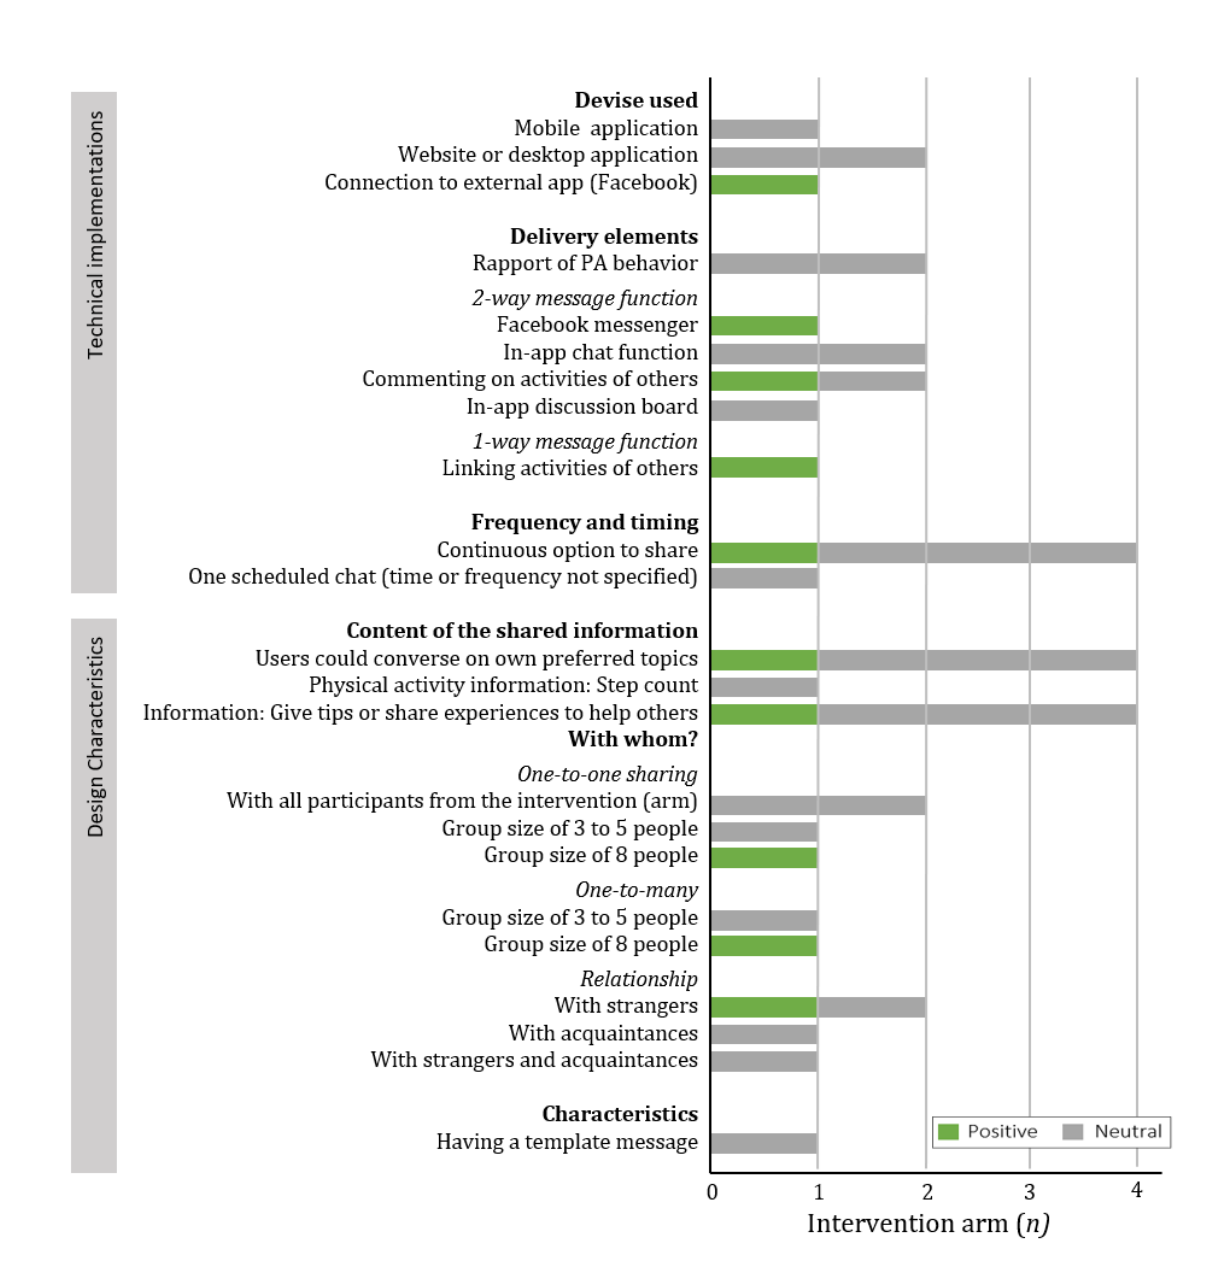
Figure 4. The effectiveness of the technical implementations and design characteristics of sharing compared with receiving no sharing function in 4 intervention arms (4 different studies). PA: physical